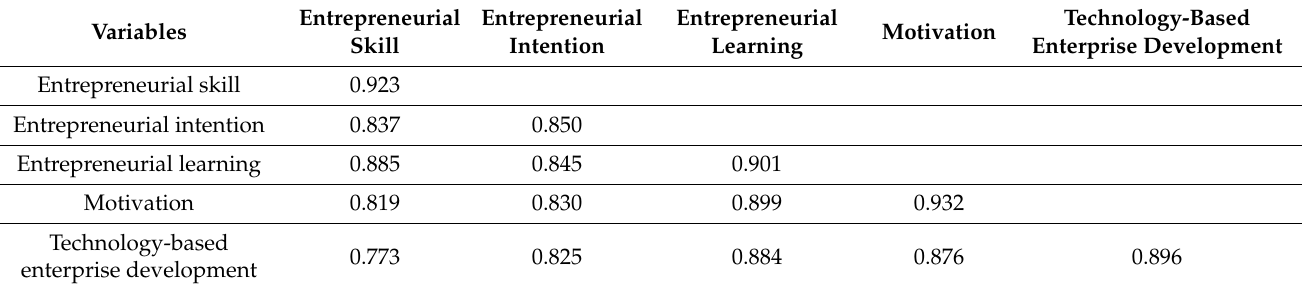
Table 2. Divergent